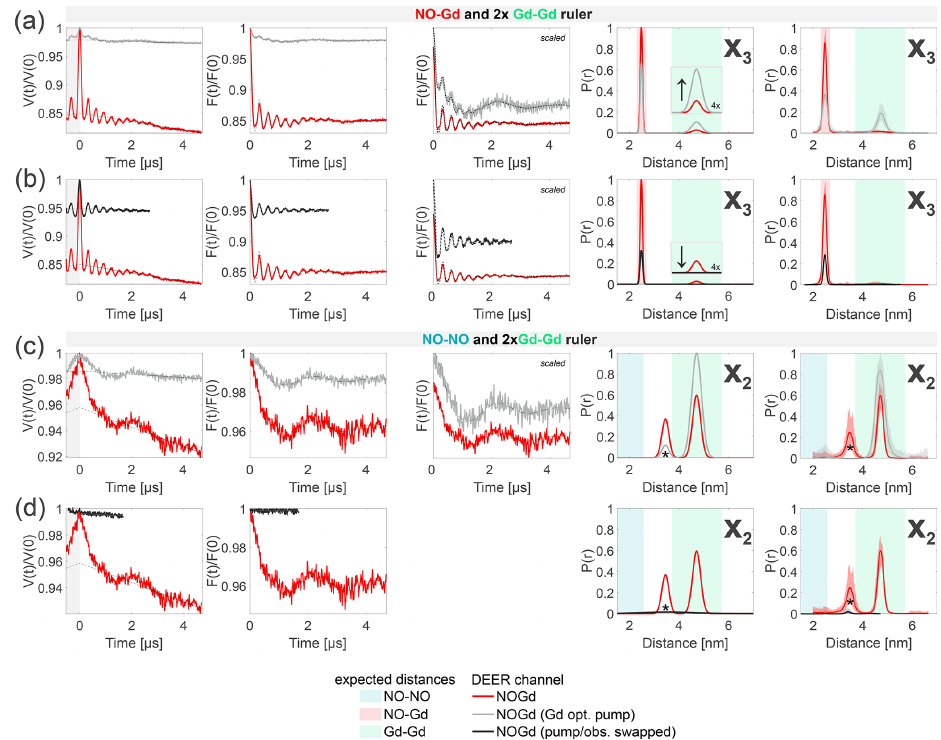
Figure 9. Crosstalk signal identification and suppression. The first column shows the primary data with background fit (gray areas are excluded from data evaluation). The second column shows the form factors with the fit obtained with a Gaussian fitting routine. The third column shows the form factors scaled to the same modulation depth and offset by a constant value. The fourth column shows the distance distributions obtained. The fifth column shows the DEERNet analysis (generic network) used to provide an error estimation. (a–b) Sample containing the NO–Gd and the Gd–Gd rulers mixed in a 1 : 2 molar ratio (related to Fig. 7). The NOGd channel contains a Gd–Gd crosstalk signal in presence of a NO–Gd distance ( X 3 ). (a) Decreasing the pump pulse power in the standard NOGd DEER setup (see Fig. 3b), from optimally pumping NO (red) to optimally pumping the Gd ( − 12dB; gray), changes the signal-to-crosstalk ratio and, thereby, allows the identification of the crosstalk signal. (b) By pumping the Gd and observing on the NO (swapped NOGd DEER setup; see Fig. 3d) the Gd–Gd crosstalk signal can be fully removed from the NOGd DEER channel (black). (c–d) Sample containing the NO–NO and the Gd–Gd rulers mixed in a 1 : 2 molar ratio (related to Fig. 6). The NOGd DEER channel contains a Gd–Gd crosstalk signal in absence of a NO–Gd distance ( X 2 ). The distance, indicated with an asterisk, originates from a spectrometer artifact. (c) Analogous to (a) . (d) Analogous to (b)